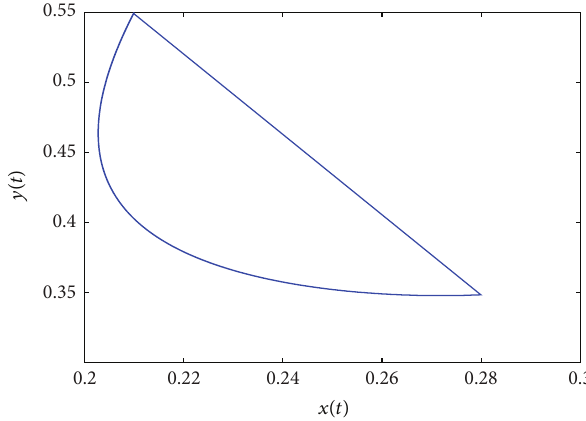
Figure 6: The phase trajectory without impulse.